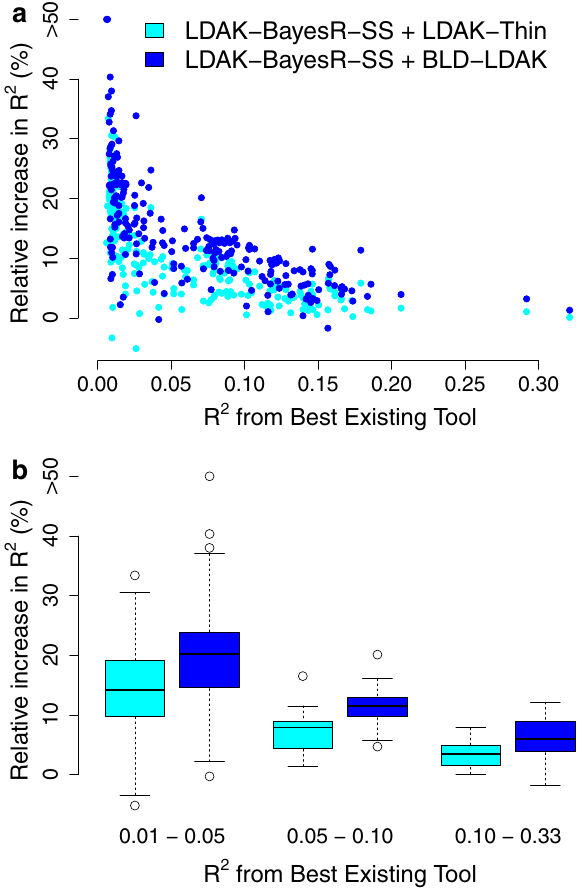
Fig. 4 Impact of changing the heritability model when using summary statistics. a For each of the 225 phenotypes, we compare PRS constructed using LDAK-BayesR-SS assuming either the LDAK-Thin or BLD-LDAK Model, to PRS constructed using our implementations of the existing tools lassosum, sBLUP, LDpred and SBayesR. We measure the accuracy of PRS via R 2 , the squared correlation between observed and predicted phenotypes. The x -axis reports highest R 2 across the four existing tools, while the y-axis reports the percentage increase in R 2 if instead of using the existing tool with highest R 2 , we use LDAK-BayesR-SS assuming either the LDAK-Thin or BLD-LDAK Model (improvements above 50% are truncated). b The same as a , except phenotypes are grouped based on highest R 2 across the four existing tools: 0.01 – 0.05 (106 phenotypes), 0.05 – 0.10 (51 phenotypes) or 0.10 – 0.33 (68 phenotypes). Boxes mark the median increase in R 2 and the inter-quartile range. Source data are provided within the Source Data fi